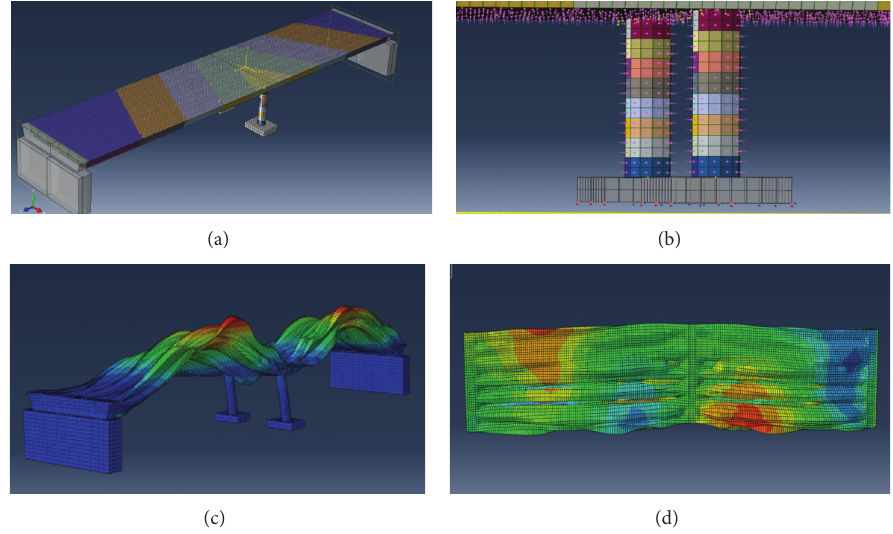
Figure 8: FE elastic analysis for a case with monolithic connections in the abutments and central pier. (a and b) Loading surfaces on the structure to model the wave transition. (c and d) Snapshots of the deformed state of the structure at the deck and around the central bent at peak displacement